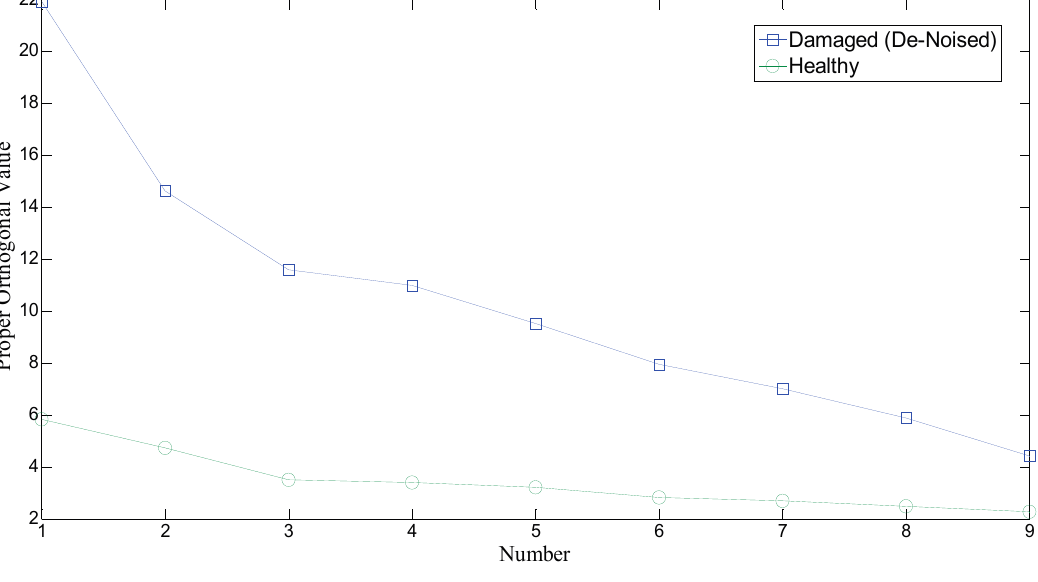
Figure 12. Proper orthogonal values of the collected covariance matrix of the IMFs from noised and wavelet-based de-noised segments (additional test